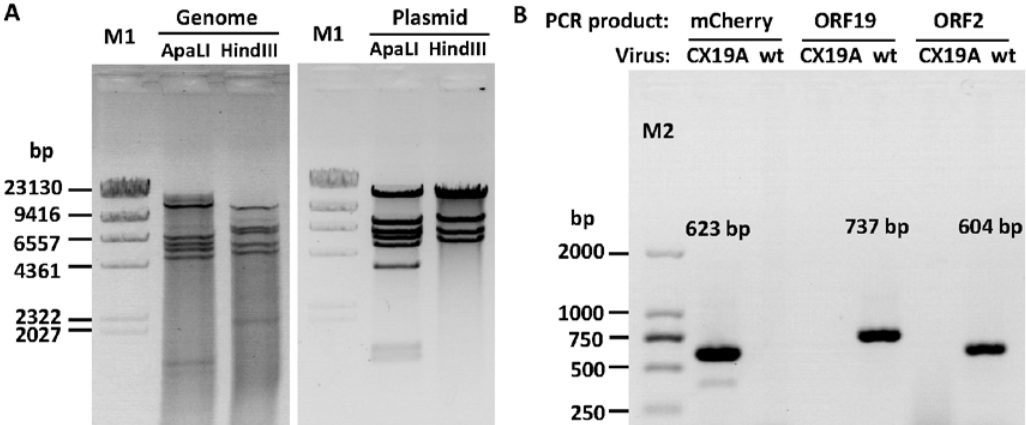
Figure 5. Identification of FAdV4-CX19A virus. ( A ) FAdV4-CX19A (mCherry–xORF19A) was identified by restriction analysis of its genomic DNA, and adenoviral plasmid pKFAV4-CX19A served as the control. The predicted molecular weights of digested fragments of the FAdV4-CX19A genome were 1312, 1447, 1450, 4879, 5592, 6113, 6904 and 13,354 bp for ApaLI; and 2119, 5216, 5900, 7413, 8047 and 12,356 bp for HindIII. The predicted molecular weights of digested fragments of pKFAV4-CX19A plasmid 1312, 1450, 3527, 4879, 5592, 6113, 7301 and 13,354 bp for ApaLI; and 5216, 5900, 7413, 12,356 and 12,643 bp for HindIII. ( B ) Identification of FAdV4-CX19A by PCR. PCR was performed to amplify fragments inside mCherry, ORF19A or ORF2 genes using the FAdV4-CX19A genomic DNA (CX19A) as the template, and the products were resolved on 1% agarose gel. Wild- type FAdV-4 genome (wt) served as the control template.